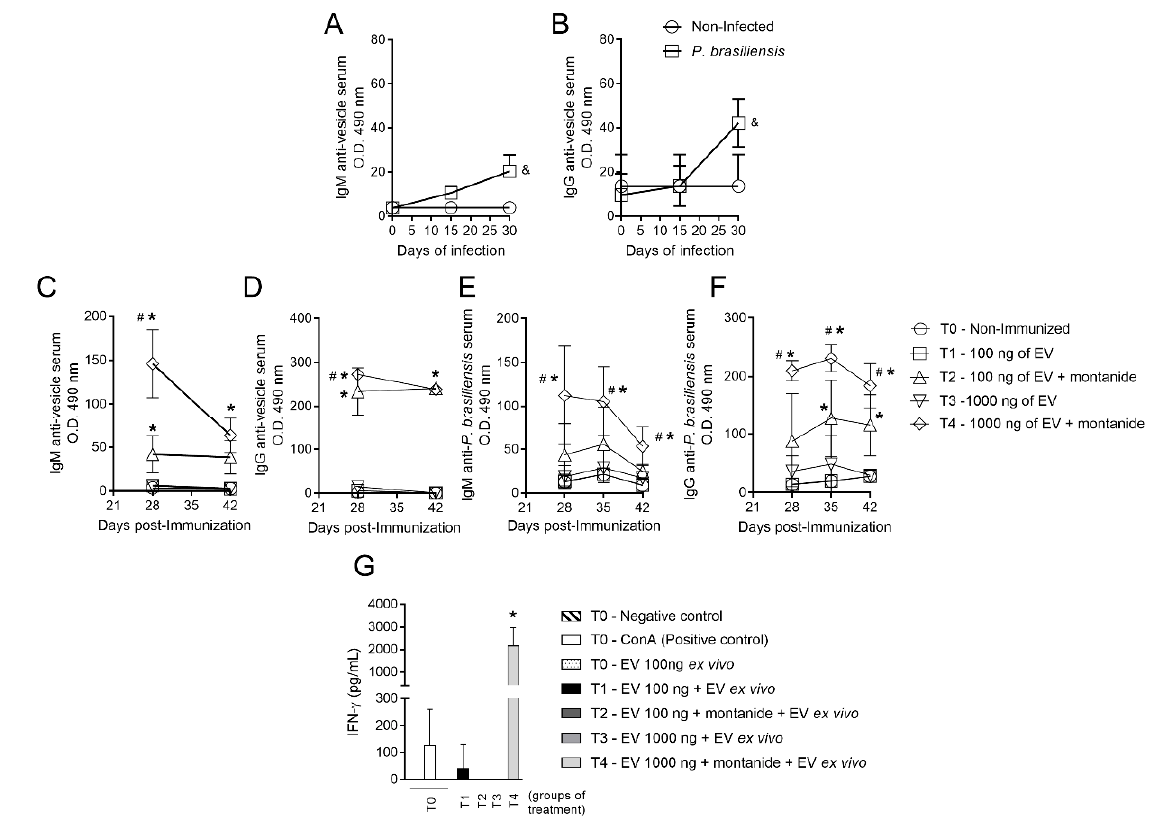
Figure 1. Standardization of the immunization with extracellular vesicles. Mice infected with P. brasiliensis yeast cells without immunization by EVs produce antibodies that recognize proteins carried by EVs from P. brasiliensis . IgM against EV-derived protein ( A ). IgG against EV-derived protein ( B ). & p ≤ 0.05, statistically significant compared to non-infected. Evaluation of IgM and IgG levels on serum after immunization with EVs in mice not infected with P. brasiliensis . IgM anti-EV-derived protein ( C ). IgG anti-EV-derived protein ( D ). IgM anti- P. brasiliensis ( E ). IgG anti- P. brasiliensis ( F ). Group T0 refers to non-immunized mice (control). Groups T1, T2, T3, and T4 refer to mice immunized with the indicated amount of EV-derived protein in the presence or absence of adjuvant. * p ≤ 0.05, statistically significant compared to non-immunized (T0), T1, and T3 groups. # p ≤ 0.05, statistically significant compared to the T2 group. Splenocytes from mice immunized with EVs but not infected with P. brasiliensis were incubated ex vivo with EVs to evaluate of IFN- γ production. ( G ). * p ≤ 0.05, statistically significant compared to non-immunized (T0), T1, T2, and T3 groups. Data represents one experiment. n = 6 animals per group.